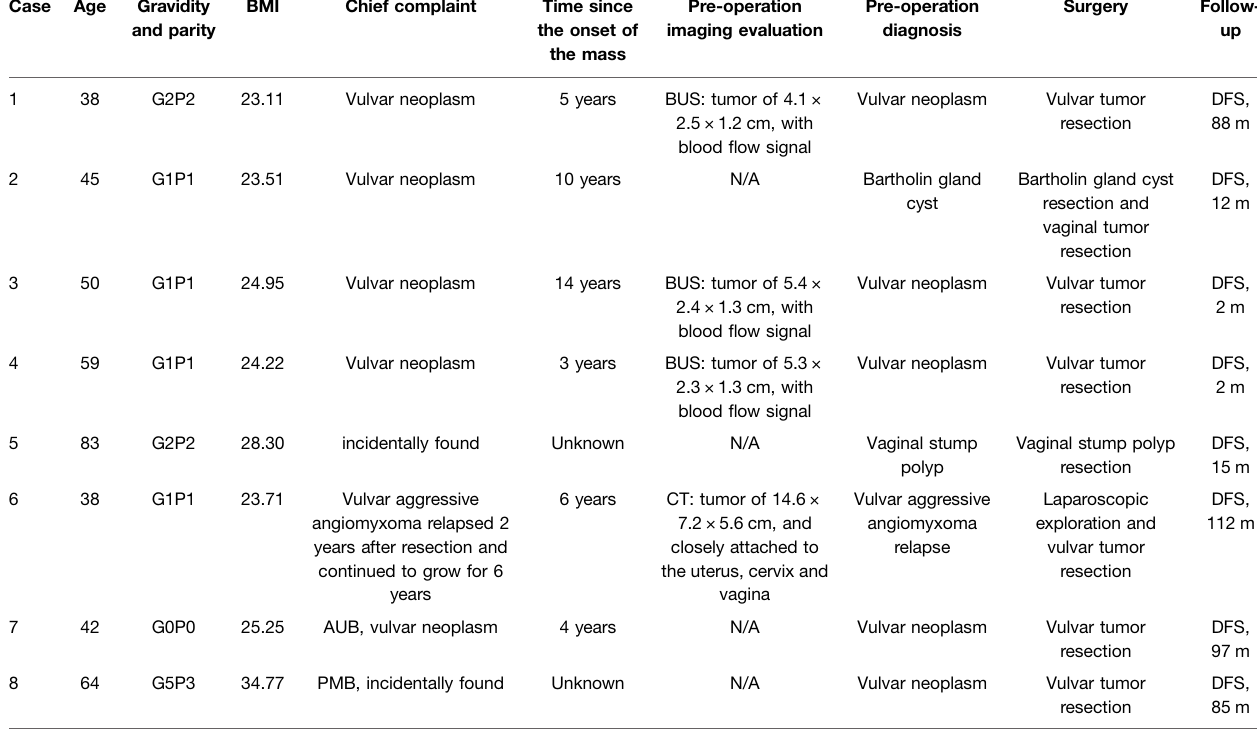
TABLE 1 | The clinical characteristics of the included patients. Case